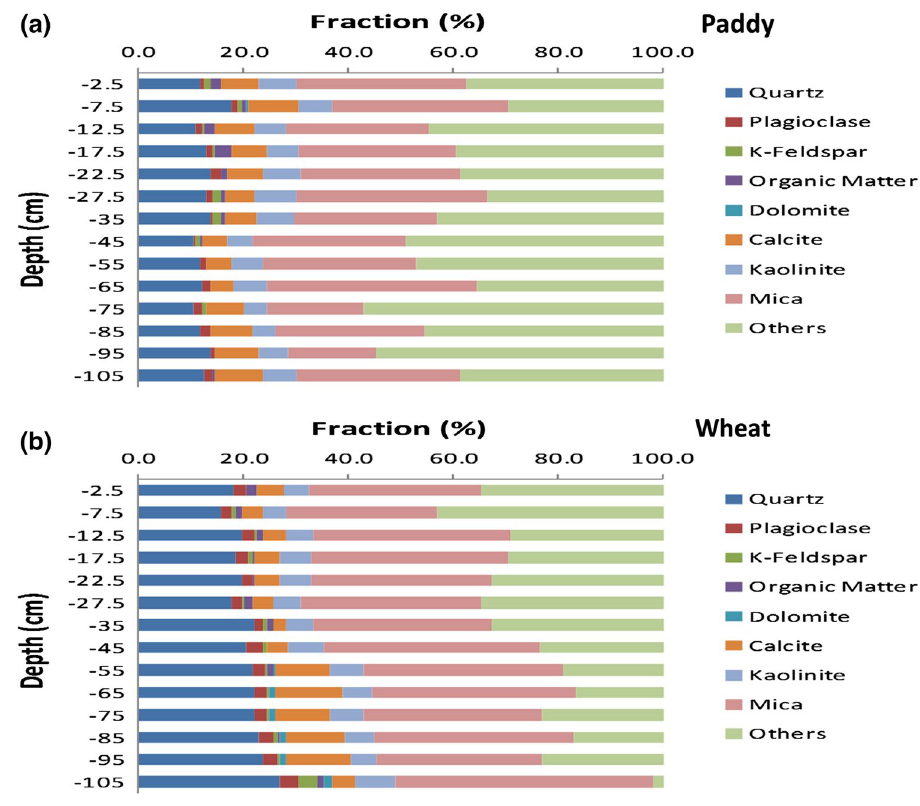
Table 2 Statistical summary of abundances of minerals in paddy and wheat soil profile (cm) Field Type